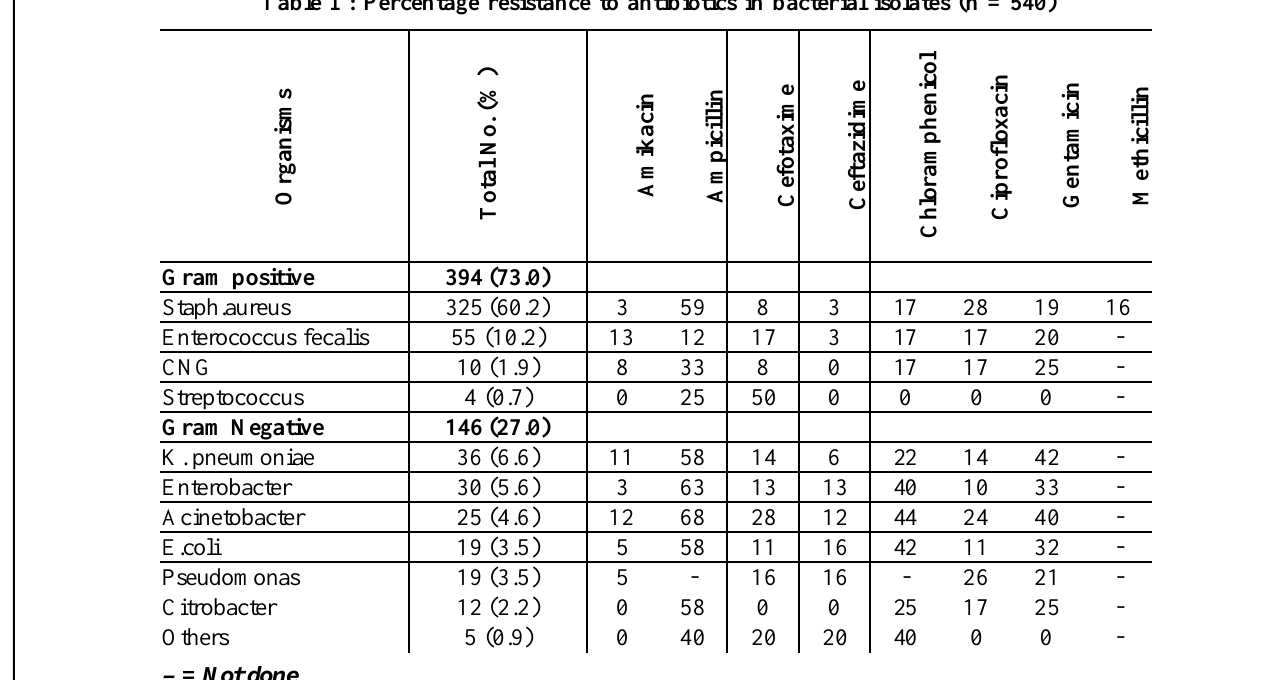
Table I : Percentage resistance to antibiotics in bacterial isolates (n = 540)